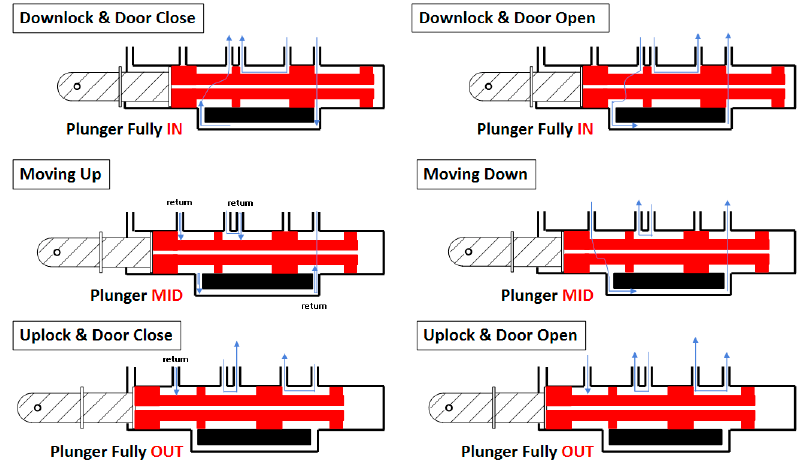
Figure 4. Hawker 800XP aircraft main landing gear reversing valve operational states [18].